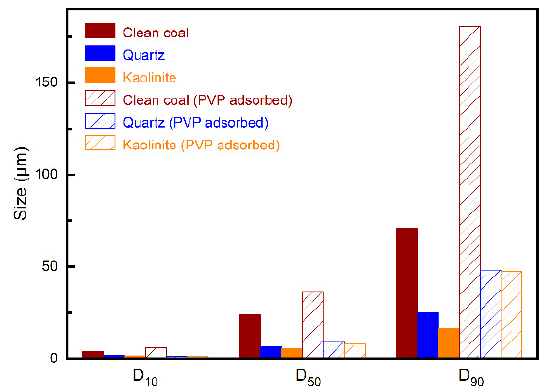
Figure 8. Size distribution of clean coal, quartz, and kaolinite (treated with 6 mg/L PVP).